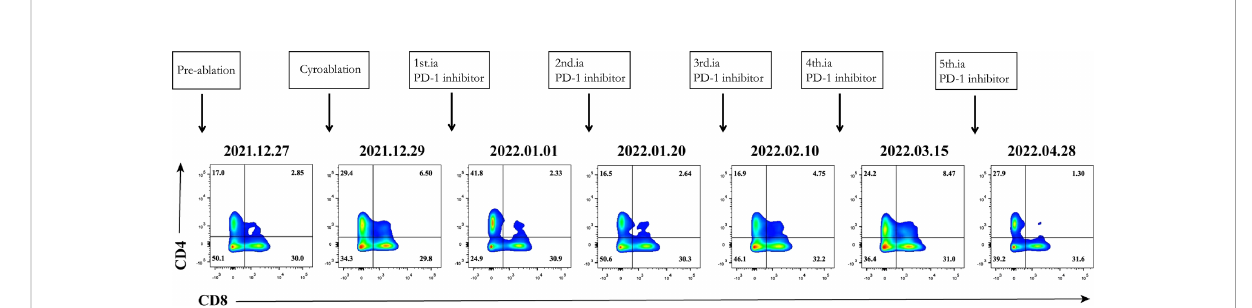
FIGURE 2 Immune correlative study of the combination therapy. Dynamic change of CD4+ T cells and CD8+ T cells.